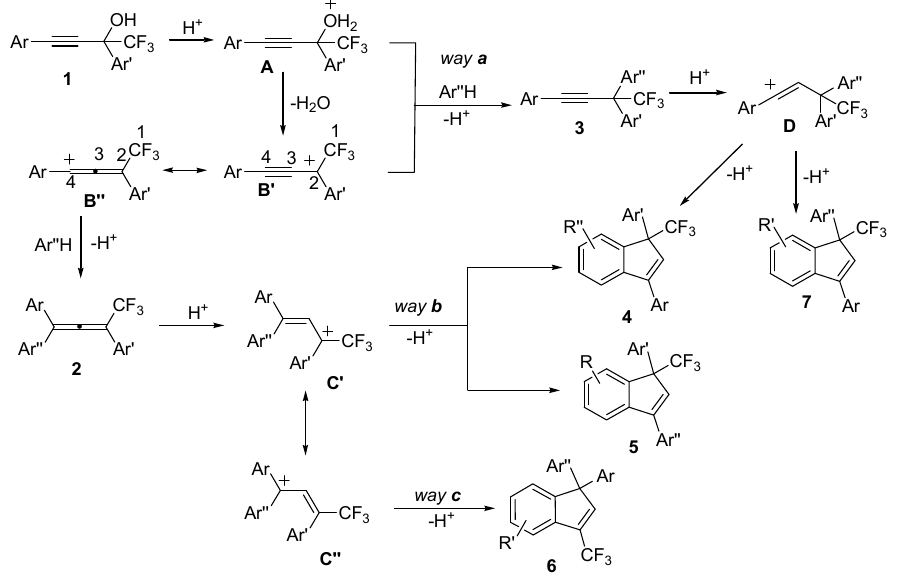
Scheme 1. Plausible mechanisms of acid-promoted reactions of CF 3 -alcohols 1 with arenes.